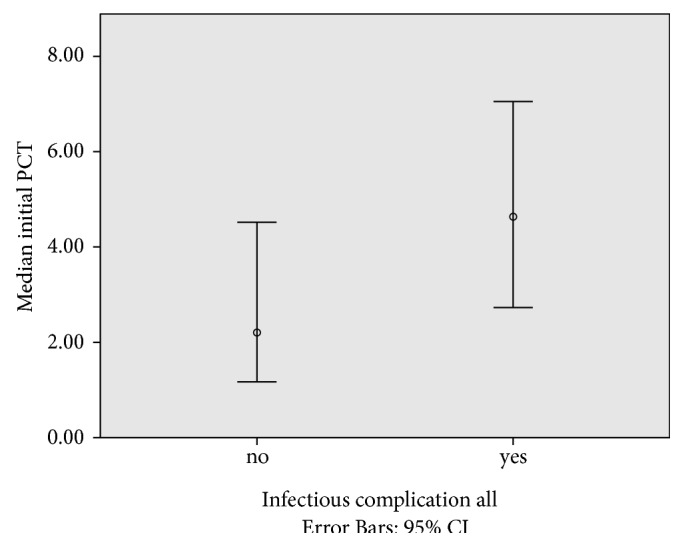
Relation initial PCT value and the occurring of postoperative infectious complications. x-axis show the group of patients with (yes) and without (no) an infectious postoperative complication. y-axis shows the median PCT value on day of surgery or postoperative day 1 in μg/l (error bars 95% CI).